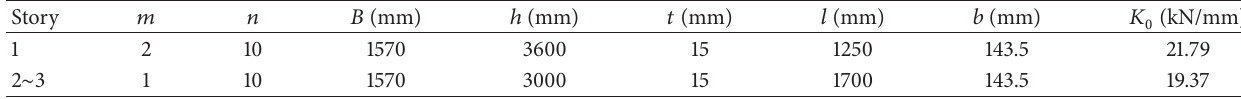
Table 6: Relevant parameters of the steel slit